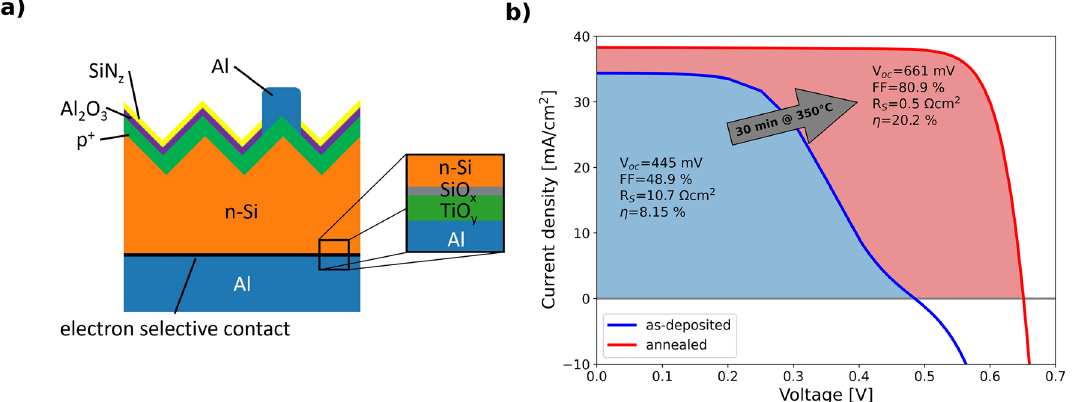
Figure 1. Characteristics of the investigated solar cells. ( a ) Schematic of the solar cells used for this study. The intended layer stack of the electron selective rear contact is shown enlarged in the black frame. ( b ) Presents the current-voltage curves of the as-deposited (blue) and annealed (red) solar cells, showing the strong improvement of solar cell efficiency with